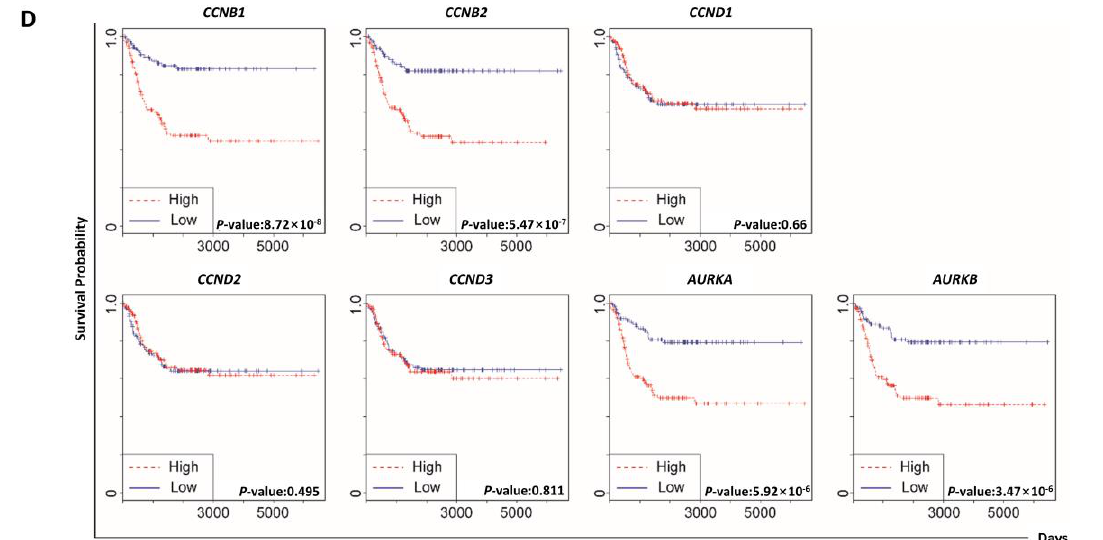
Figure 3. Expression patterns of mitosis-regulatory genes in neuroblastoma patients. ( A ) Gene-expression patterns of CCNB1 , CCNB2 , CCND1 , CCND2 , CCND3 , AURKA , AURKB , PLK1 , and TP53 in GSE49710. ANOVA tests for all stages in the genes were performed ( p -values: CCNB1 , 2 × 10 − 16 ; CCNB2 , 4.57 × 10 − 5 ; CCND1 , 0.081; CCND2 , 3.83 × 10 − 9 ; CCND3 , 0.000346; AURKA , 2 × 10 − 16 ; AURKB , 1.71 × 10 − 13 ; PLK1 , 2 × 10 − 16 ; TP53 , 0.000786). The y -axis indicates messenger RNA (mRNA) expression. ( B ). Gene-expression patterns of CCNB1 , CCNB2 , AURKA , and AURKB in GSE85047, according to stages ( p -values of ANOVA tests: CCNB1 , 3.95 × 10 − 7 ; CCNB2 , 7.15 × 10 − 6 ; CCND1 , 0.898; CCND2 , 0.42; CCND3 , 0.336; AURKA , 8.63 × 10 − 7 ; AURKB , 4.62 × 10 − 5 . The y -axis indicates mRNA expression. ( C ) Progression-free survival plots and log-rank test p -values of CCNB1 , CCNB2 , CCND1 , CCND2 , CCND3 , AURKA , and AURKB in GSE85047. ( D ) Overall survival plots and log-rank test p -values of CCNB1 , CCNB2 , CCND1 , CCND2 , CCND3 , AURKA , and AURKB in